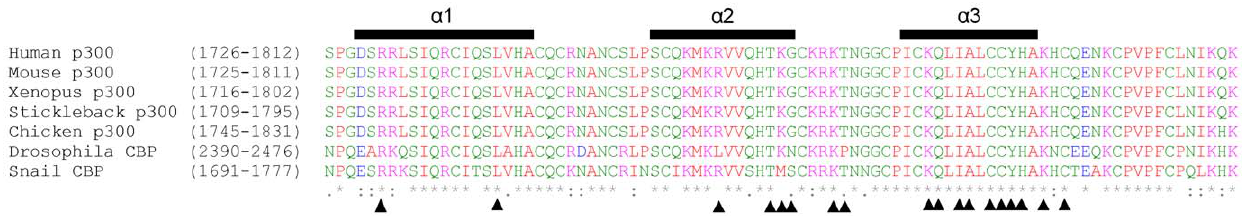
Figure 8. Multiple sequence alignment of the highly homologous TAZ2 domains of p300 and CBP. The multiple sequence alignment of the TAZ2 domain of human, mouse, western clawed frog (Xenopus tropicalis), stickleback and chicken p300, and drosophila and pond snail CBP, illustrates the high degree of sequence homology between the TAZ2 domains of a diverse range of species. Residues are coloured according to the residue type, with small and hydrophobic residues in red (AVFPMILW), acidic residues in blue (DE), basic residues in magenta (RK) and residues containing a hydroxyl, sulfhydryl or sidechain amide group in green (STYHCNQ). Glycine was also coloured in green. Consensus symbols are shown below the sequence. Residues marked with an ‘*’ were fully conserved between sequences. The symbol ‘:’ indicates conservation between groups with strongly similar properties and ‘.’ indicates conservation between groups of weakly similar properties. TAZ2 residues that were significantly shifted upon binding to B-Myb are indicated by triangles shown below the consensus. The positions of the helices in p300 TAZ2, which were identified by analysis of the backbone resonance assignments using the chemical shift index method are indicated above the sequence. The alignment was prepared using